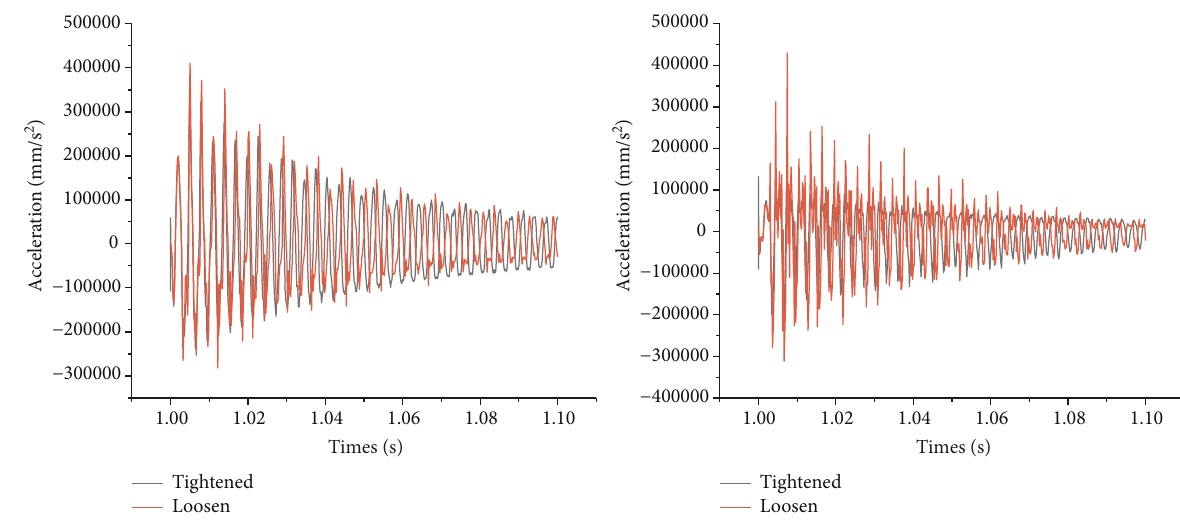
Figure 21: X and Y direction acceleration response (under 1.5 kN impact load on the